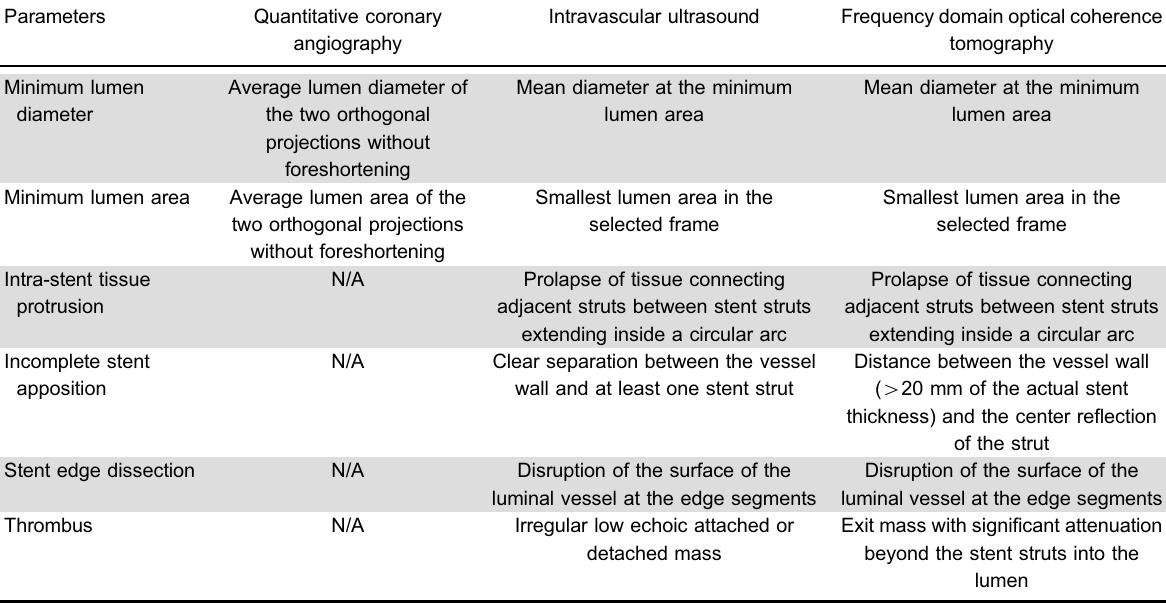
Table 1. Parameters of image